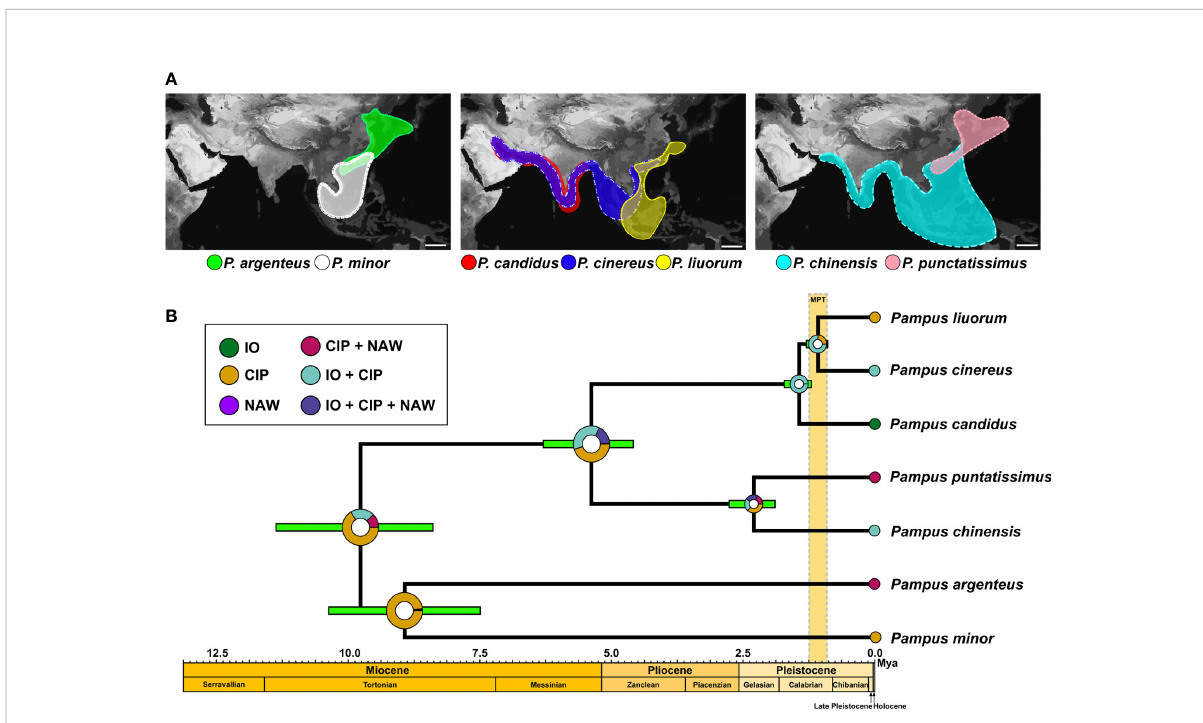
FIGURE 5 Divergence time inference and ancestral reconstruction of the seven Pampus species. (A) Distributions of each lineage of genus Pampus based on mitochondrial data; scale bars at lower-right corner of the maps indicate 1,000 km. (B) Divergence time inference and ancestral state reconstruction in BEAST v1.10.4 and RASP v4.2. IO, Indian Ocean; CIP, Central Indo-Paci fi c; NAW, Northeast Asian waters. The intervals of the geographic epochs are plotted based on Steinthorsdottir et al. (2021). The interval of the Mid-Pleistocene transition (MPT) is plotted based on Petrick et al.